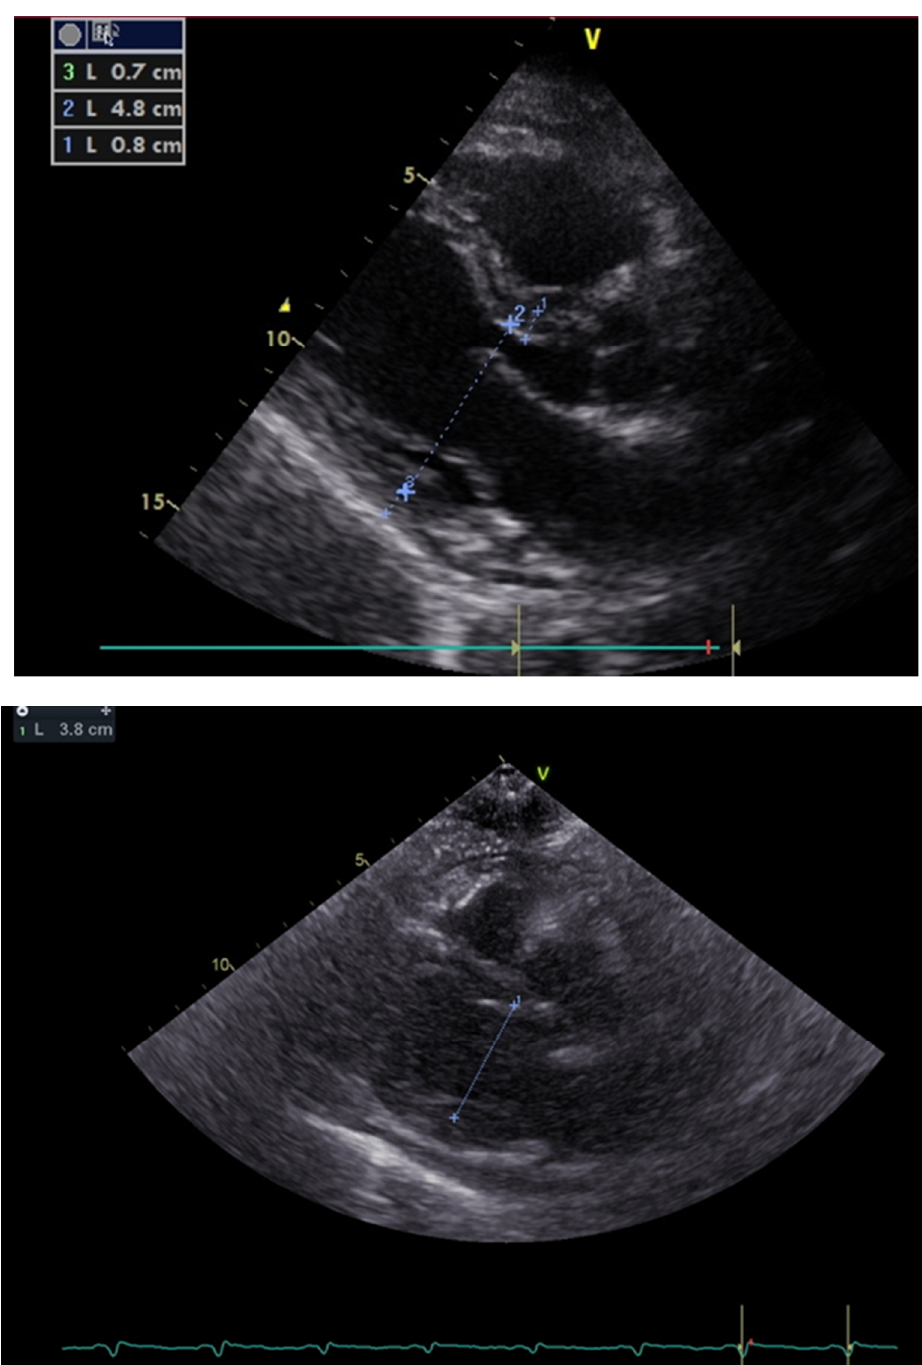
Figure 5. Markedly decreased left ventricular diastolic diameter from long axis parasternal view within 20 days.